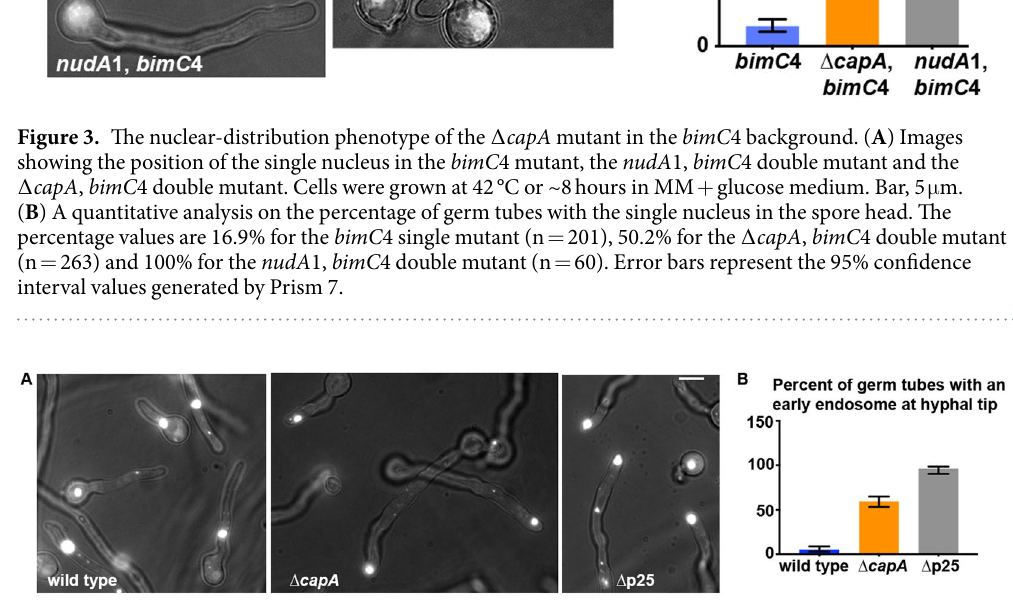
Figure 4. Early endosome-distribution phenotype of the ∆ capA mutant. ( A ) Images showing large early endosomes labeled by overexpressed GFP-RabA in wild type and the ∆ capA mutant. Cells were grown at 37 °C for ~8 hours in MM + glucose medium. The ∆ p25 mutant defective in the dynein-early endosome interaction was used as a control. Bar, 5 μ m. ( B ) A quantitative analysis on the percentage of germ tubes with a large early endosome located at the hyphal tip. The percentage values are 5.1% for wild type (n = 234), 59.4% for the ∆ capA mutant (n = 271), and 96% for the ∆ p25 mutant (n = 100). Error bars represent the 95% confidence interval values generated by Prism